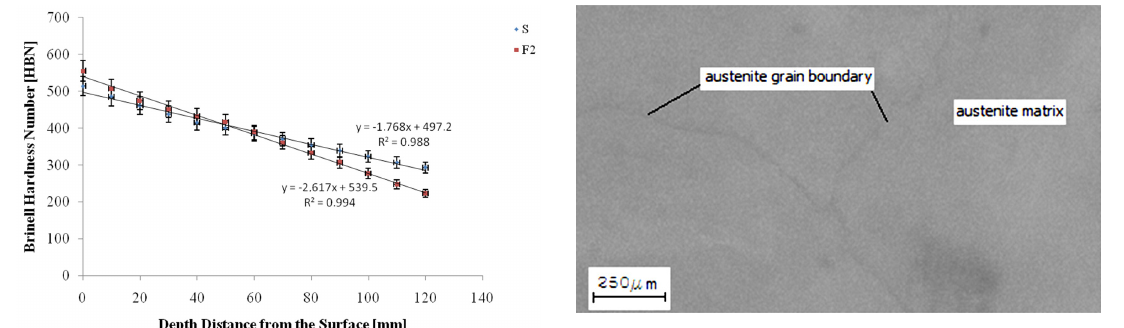
Figure 7. Optical micrograph of sample of sound crusher jaw(s) showing austenite grain boundaries in austenite matrix.